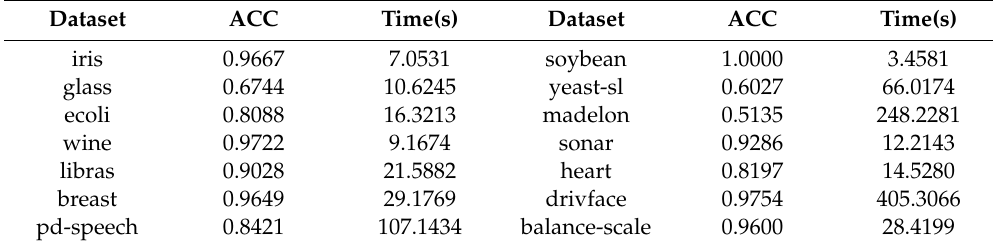
Table 7. Results for single-label datasets obtained by CNN.